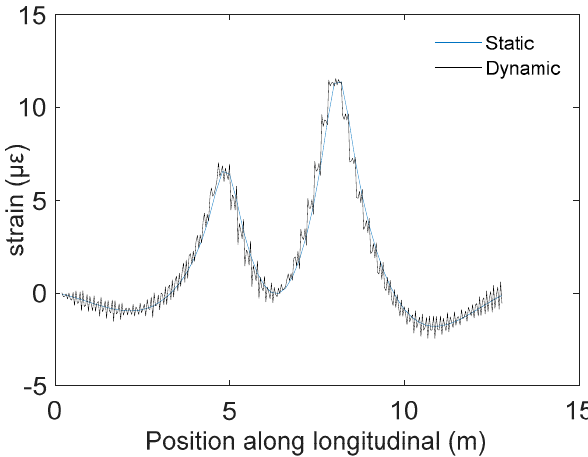
Figure 8. The static and dynamic response of N2.